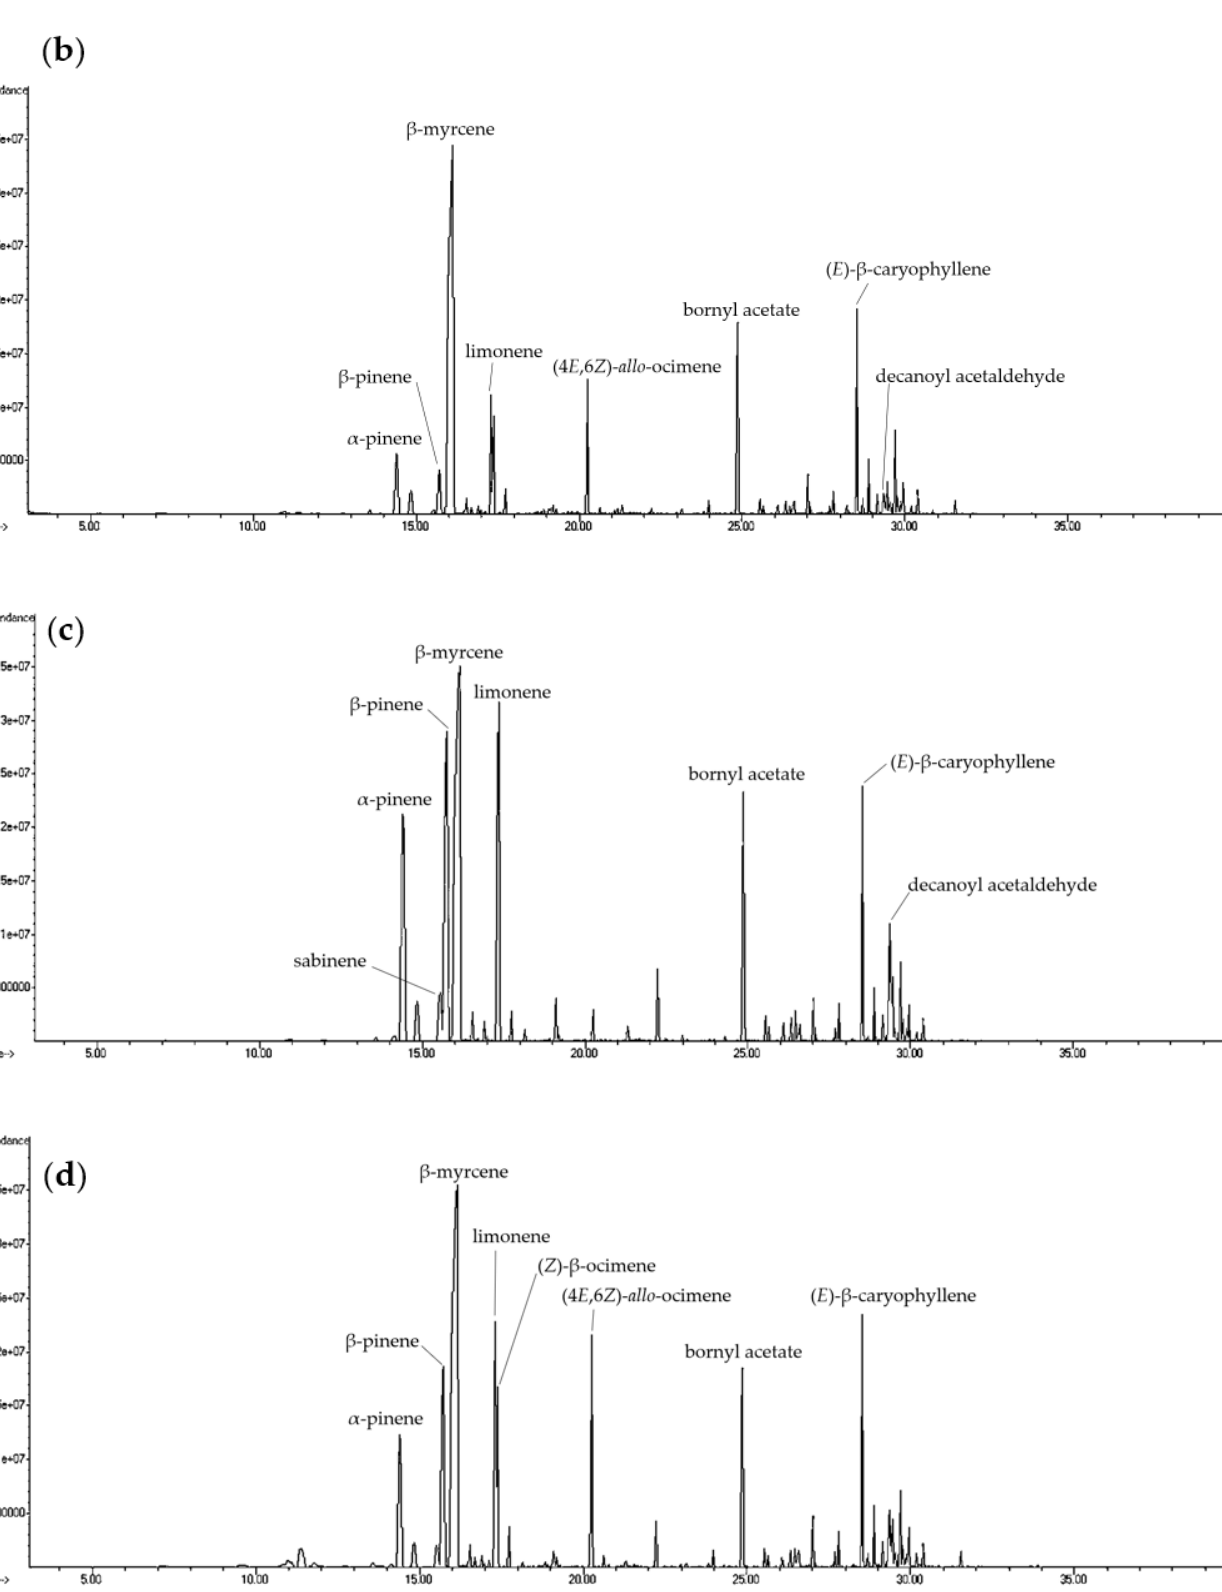
Figure 1. Ion chromatogram of volatile compounds from different parts of fresh H. cordata analyzed by HS-SPME: ( a ) leaf; ( b ) stem; ( c ) rhizome; and ( d ) whole plant.